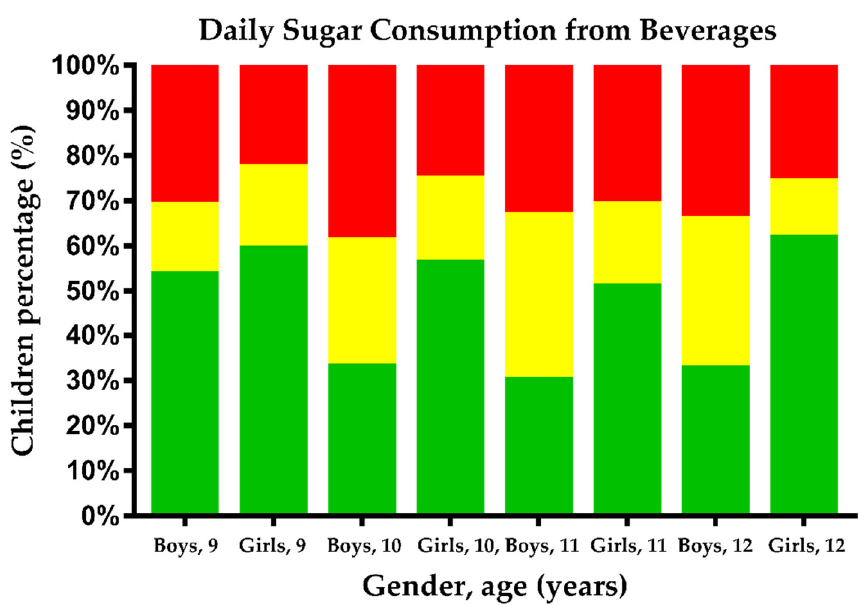
Figure 1. Daily sugar consumption from beverages in children by gender. Bars in green represent the percentage of children who consume less than 25 g of sugar per day, bars in yellow represent those who consume from 25 to 50 g of sugar per day, and bars in red represent those who consume more than 50 g of sugar per day.